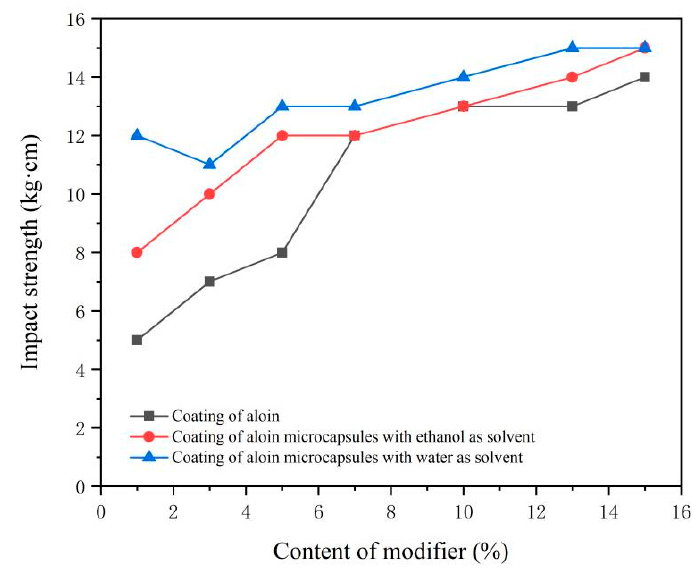
Figure 7. Impact strength of coatings with different content of modifiers.